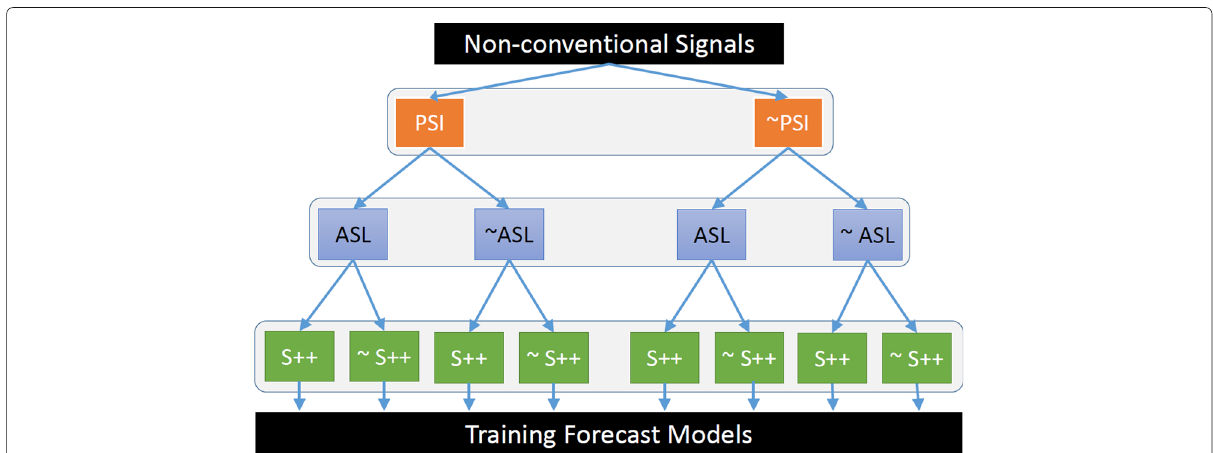
Fig. 4 An overview of the comprehensive treatment applied in this paper. A ∼ symbol before the acronym of a method shows that the corresponding method is not